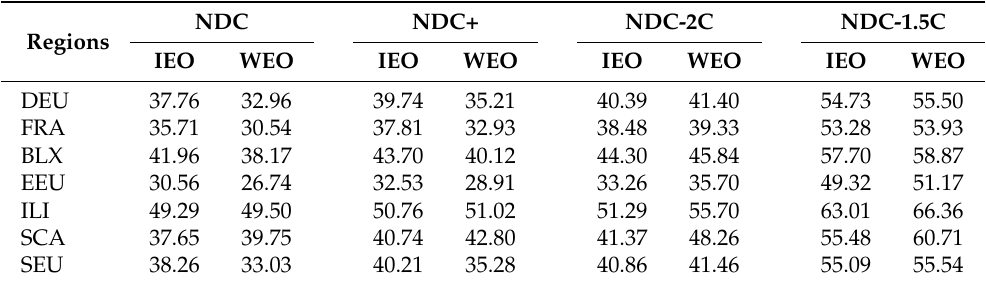
Table 4. NDCs for the EU regions for the IEO and WEO baselines (expressed in percentage reduction against the baseline in